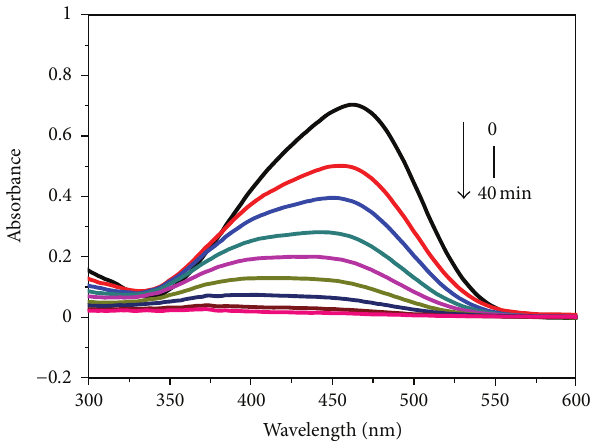
Figure 5: UV-Vis spectrum of MeOr under sunlight, using the photocatalytic membrane reactor with the ZnO NPs in suspension.